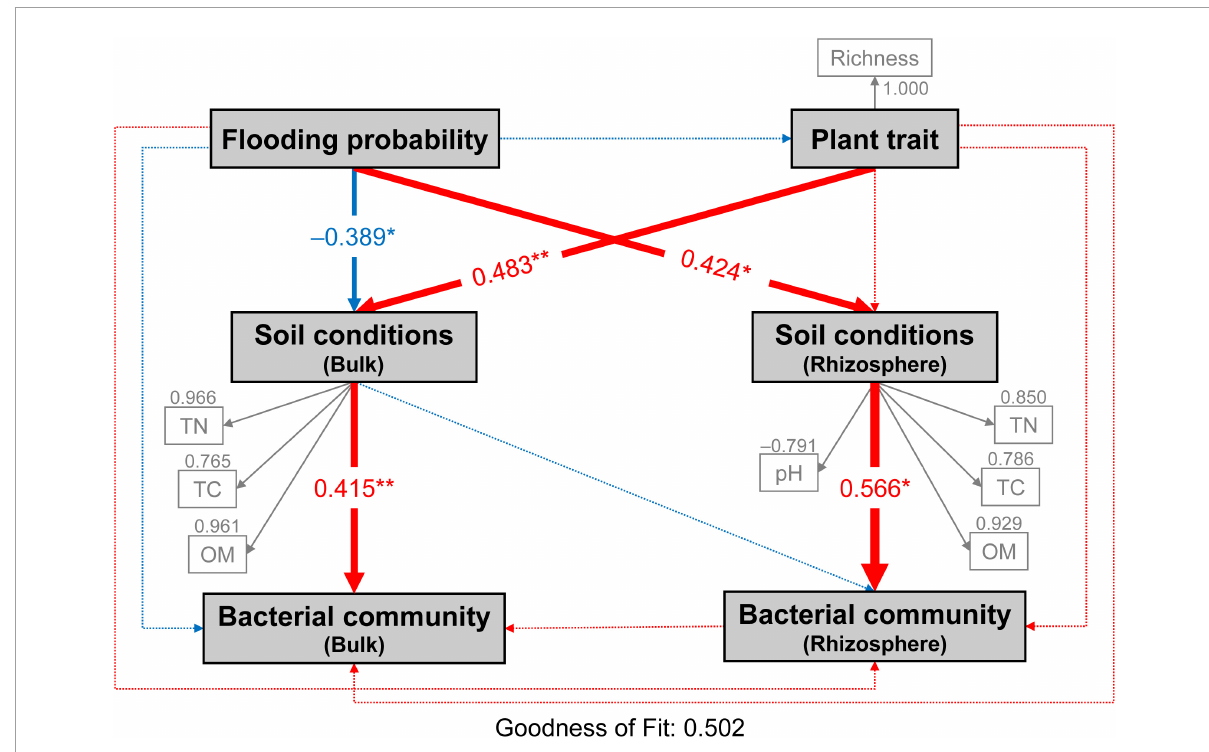
FIGURE7 Directed graph of the partial least squares path model (PLS-PM) showing the effects of flooding disturbance and plant trait on the bacterial communities of bulk and rhizosphere soil. Flooding probability represents the flooding disturbance which is calculated as the percentage of times (days) each site was flooded in the past year until sampling day. Each box represents observed or latent variables. The observed variables with loading < 0.7 were excluded in the PLS-PM construction. Larger path coefficients are reflected in the width of the arrow with red indicating a positive effect and blue indicating a negative effect. Path coefficients differ significantly from zero are indicated by “*” or “**” at 0.05 or 0.01 significance level based on 1,000 resampled bootstraps. TN, total nitrogen; TC, total carbon; OM, organic matter; Richness, plant